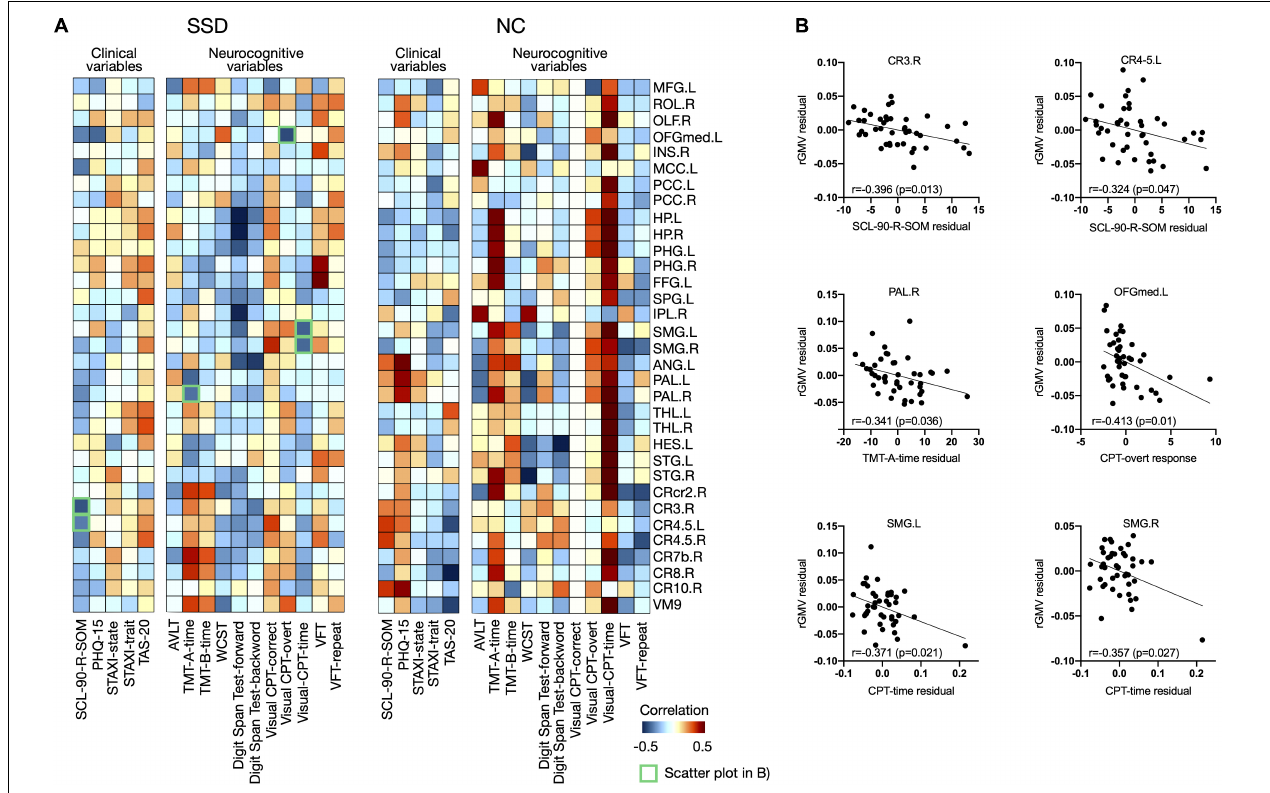
FIGURE 4 | (A) Associations between clinical/neurocognitive variables and rGMVs in the whole brain for each group and (B) remarkable negative correlations among them, presented as scatter plots, are marked as green boxes in panel (A) . rGMV, regional gray matter volume; SSD, somatic symptom disorder; NC, normal control; MFG, middle frontal gyrus; ROL, Rolandic gyrus; OLF, olfactory cortex; OFGmed, medial orbitofrontal gyrus; INS, insula; MCC, middle cingulate cortex; PCC, posterior cingulate cortex; HP, hippocampus; PHG, parahippocampal gyrus; FFG, fusiform gyrus; SPG, superior parietal gyrus; IPL, inferior parietal lobule; SMG, supramarginal gyrus; ANG, angular gyrus; PAL, pallidum; THL, thalamus; HES, Heschl’s gyrus; STG, superior temporal gyrus; CRcr2, cerebellar crus 2; CR3, cerebellar lobe 3; CR4.5, cerebellar lobes 4–5; CR7b, cerebellar lobe 7b; CR8, cerebellar lobe 8; CR10, cerebellar lobe 10; VM9, vermis 9; L, left; R, right; SCL-90-R-SOM, Somatization subscale from Symptom Checklist-90-Revised; PHQ-15, Patient Health Questionnaire-15; STAXI, State-Trait Anger Expression Inventory; TAS-20, Toronto Alexithymia Scale-20; AVLT, Auditory Verbal Learning Test; TMT, Trail-Making Test; WCST, Wisconsin Card Sorting Test; CPT, Continuous Performance Test; VFT, Verbal Fluency